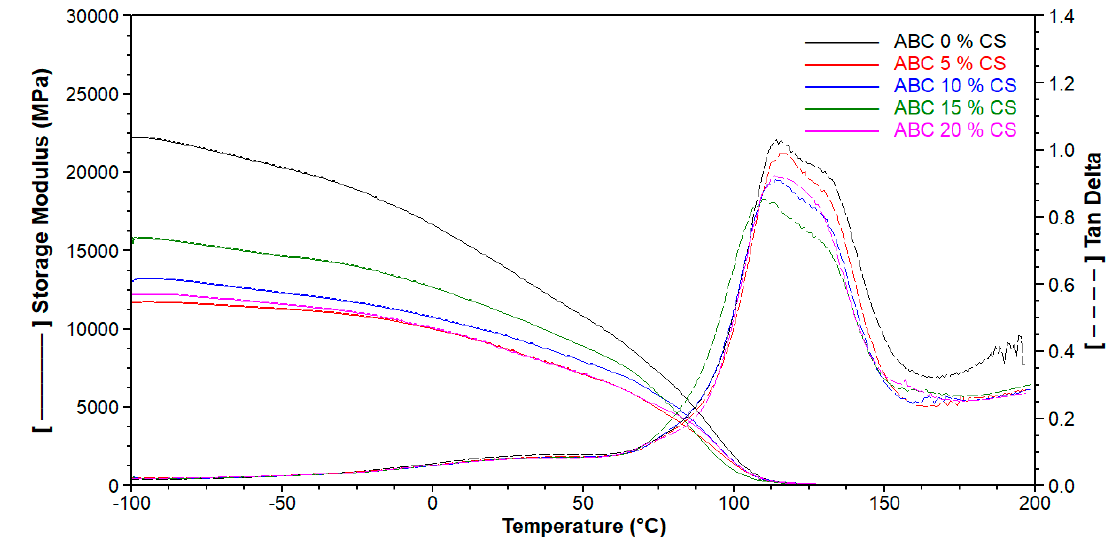
Figure 4. SEM micrographs (100 × ) of surfaces of ABCs loaded with CS. ( a ) ABC 0% CS, ( b ) ABC 5% CS, ( c ) ABC 10% CS, ( d ) ABC 15% CS, and ( e ) ABC 20% CS.